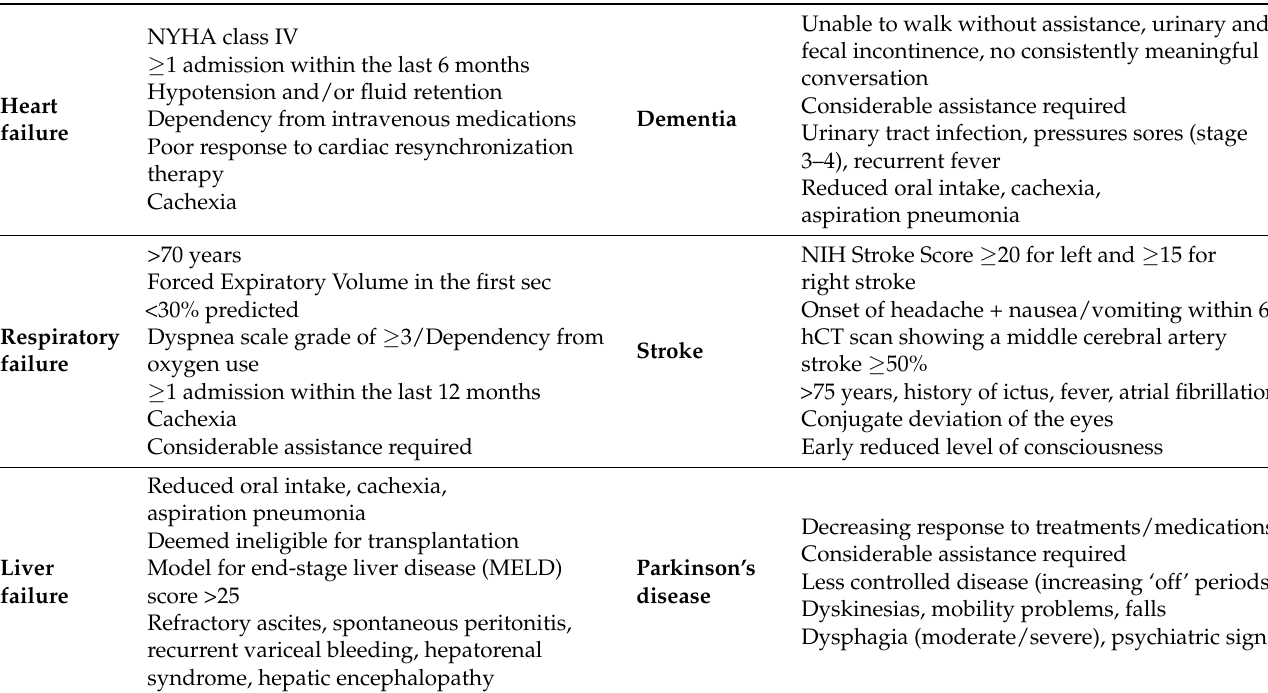
Table 2. Clinical indicators specific for each chronic